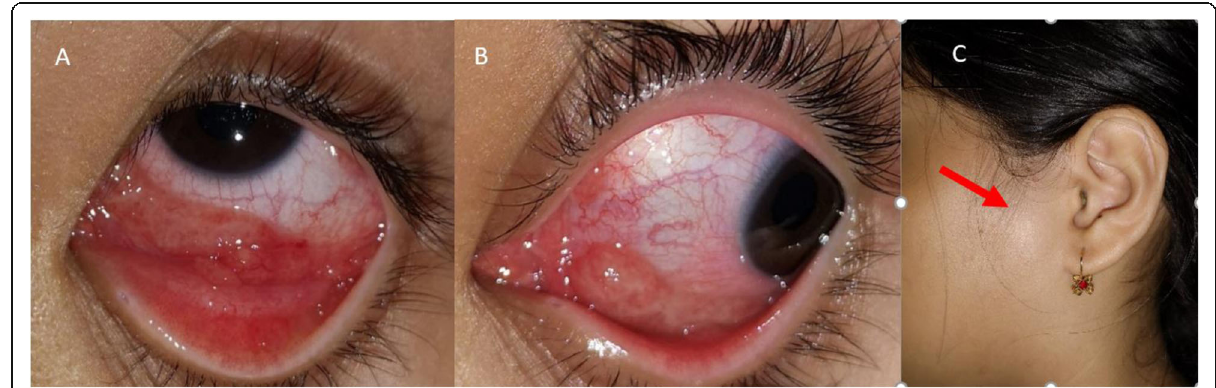
Fig. 3 Patient no. 10. A 11-year old girl with history of cat scratch presented with left eye redness, fever, cervical and pre-auricular lymph nodes swelling. a and b Granulomatous nodules on left lower tarsal and bulbar conjunctivae. c Red arrow showing pre-auricular lymph node enlargement